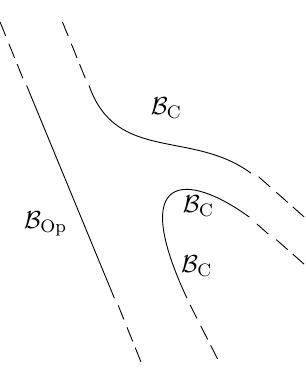
Figure 3 . The action of the algebra of ( B c , B c ) strings on the space of states of ( B c , B Op ) can be realized by attaching the ( B c , B c ) string to the end of the ( B c , B Op ) string. act on H and H respectively. These are expected to be the same quantized ( B c , B Op ) ( B c , B 0 ) Op algebra, albeit with different deformation